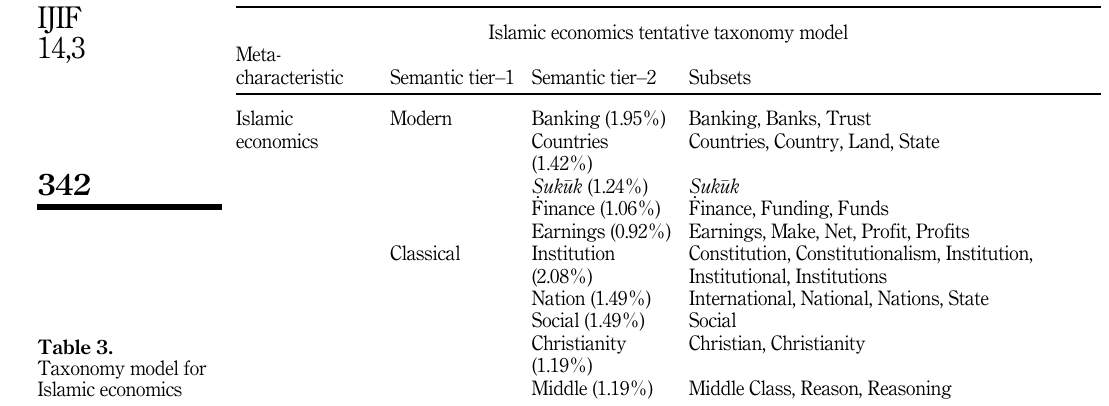
Table 3. Taxonomy model